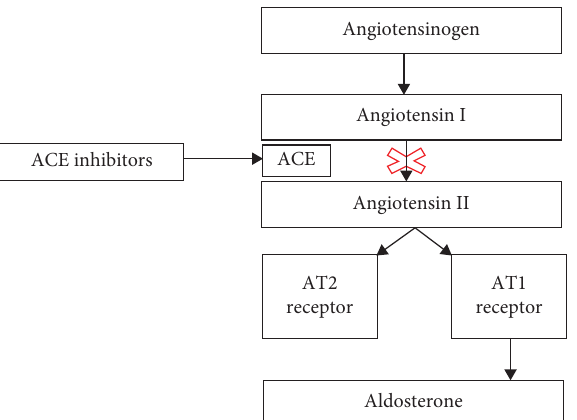
Figure 1: Effects of ACE-inhibitors on angiotensin conversion. ACE-inhibitors suppress the ACE enzyme action, thus blocking the conversion of angiotensin I to angiotensin II and its action on AT2 and AT1 receptors. The interaction between angiotensin II and AT1 receptors leads to aldosterone